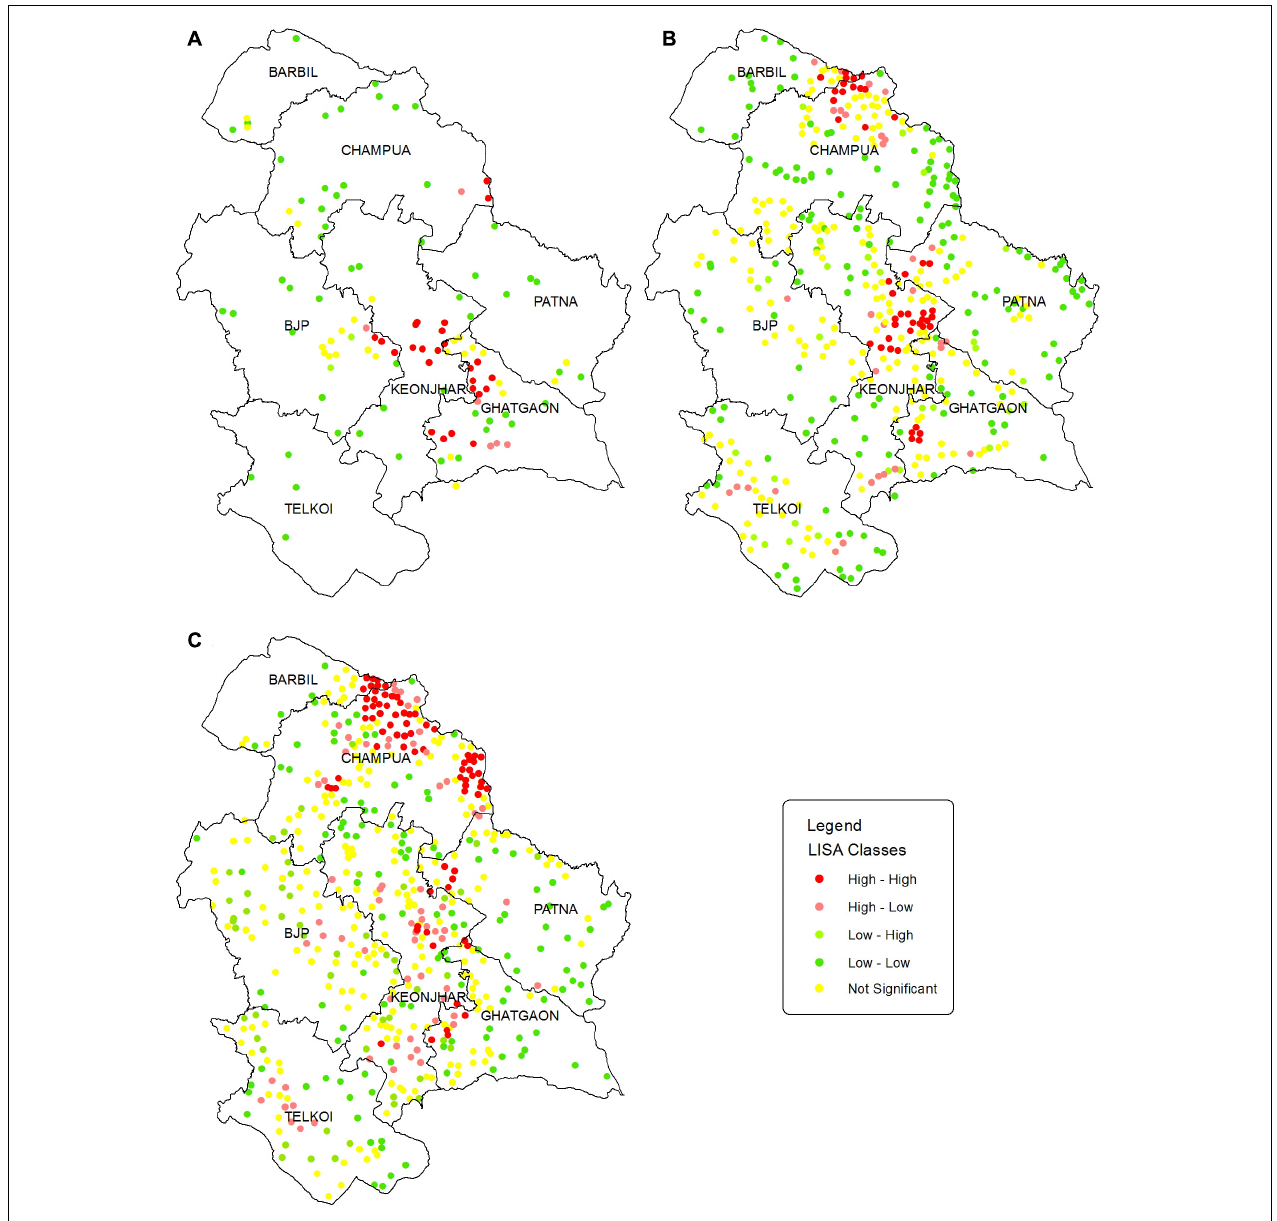
FIGURE 5 | Maps showing the LISA significant point clusters for HEC incidences in Keonjhar district for (A) HEC1, (B) HEC2, and (C) HEC3. LISA cluster maps were classified into 4 classes based on Moran scatterplot categorization. The HEC cases having p -values larger than 0.05 were classified as not significant and shown in yellow dots. The dark red and dark green locations are indications of positive autocorrelation (HH; high HEC values surrounded by high, and LL; low HEC values surrounded by low) while, the light green and light red are negative autocorrelation indications (LH; low surrounded by high and HL; high surrounded by low HEC